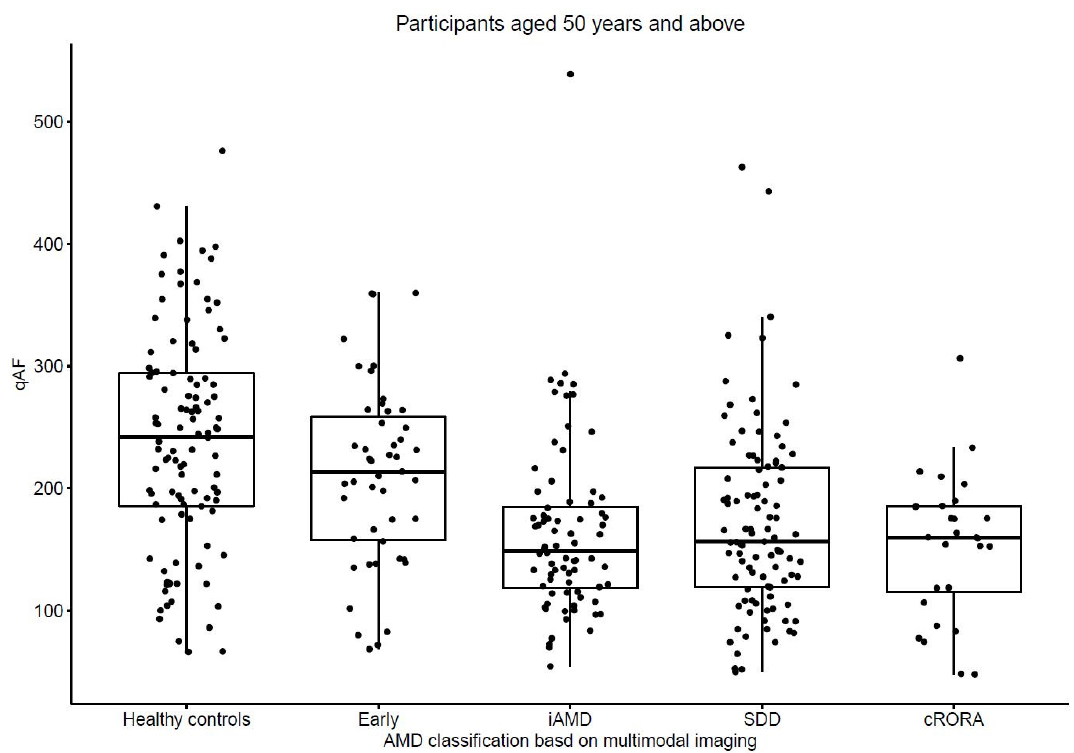
Figure 1. Mean qAF8 values in multimodal imaging categories of AMD versus age-matched controls. The multimodal imaging AMD classification shown on the x ‐ axis. Comparison was with age ‐